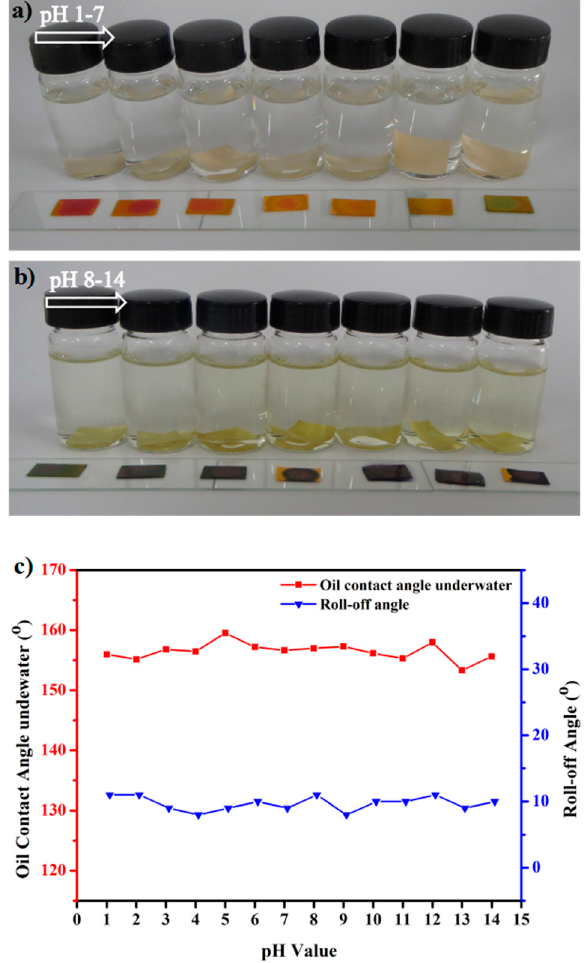
Figure 11. The CSPNM after being immersed in solutions with different pH values: ( a ) pH 1 to 7; and ( b ) pH 8 to 14. ( c ) Variation in the oil CAs under water and water CAs of the membrane with increasing pH.